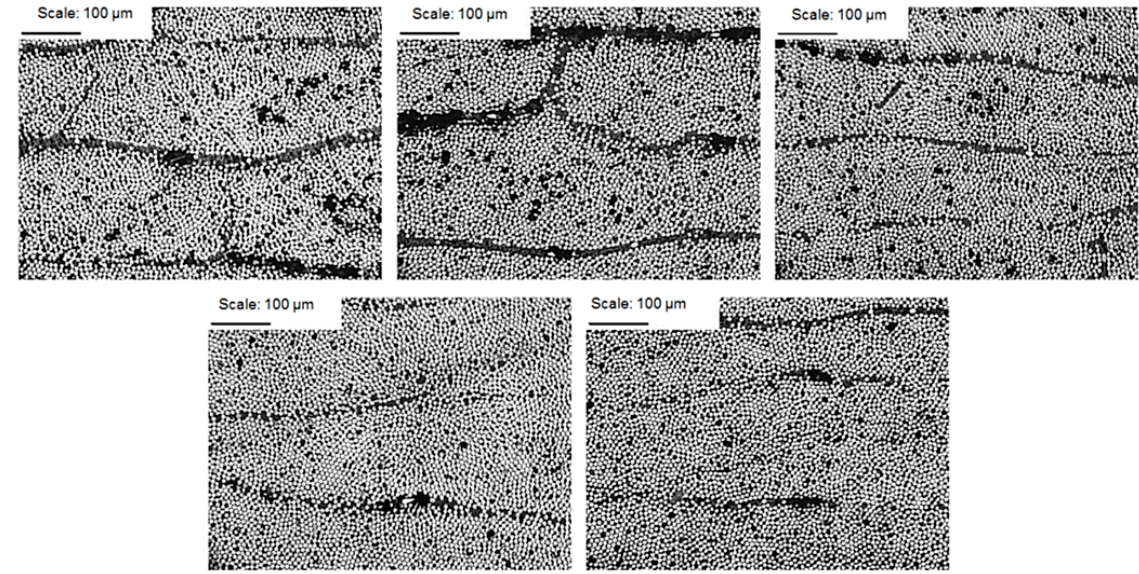
Figure 9. CFRP composite microstructure photomicrographs; magnification of 200 × for samples 1–5.